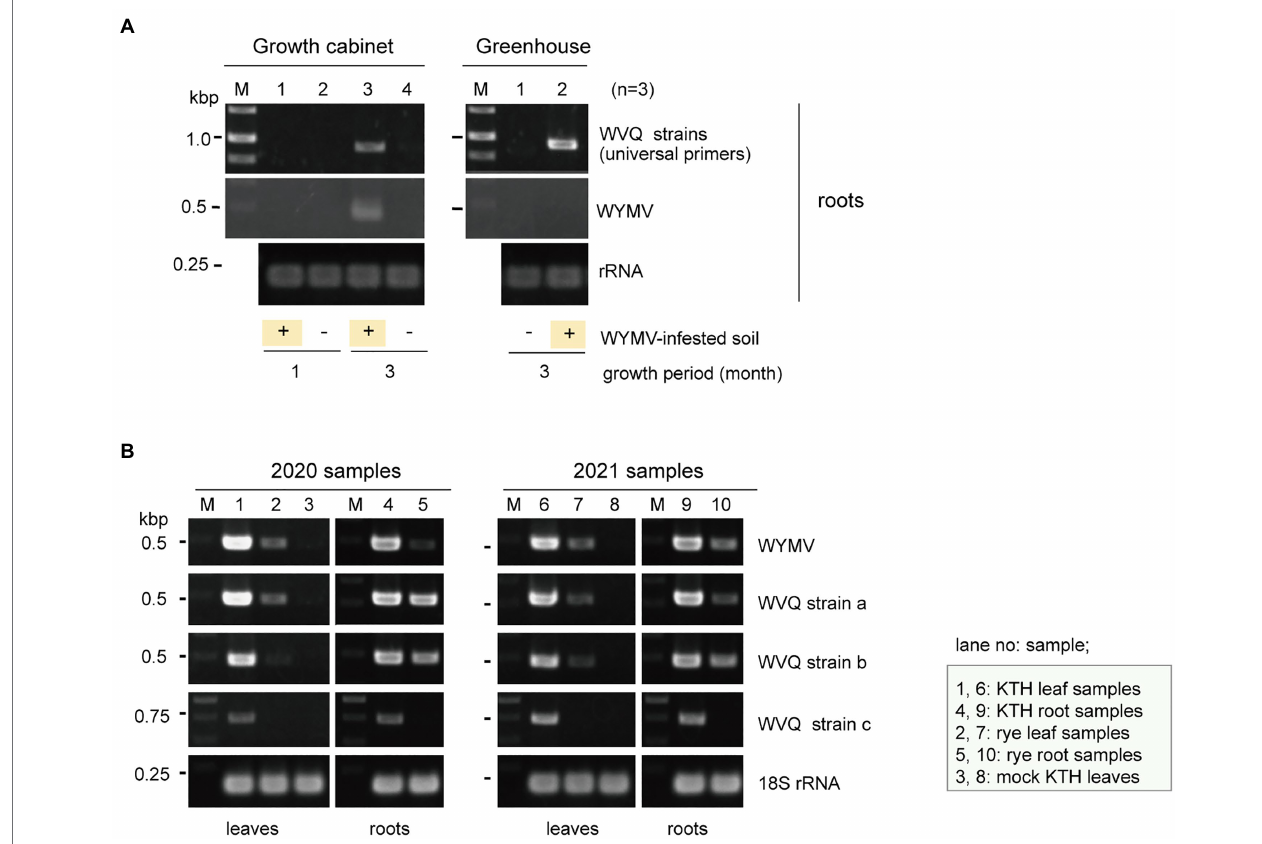
FIGURE 6 | (A) Transmission assay of WVQ. RT-PCR detection of viruses in the roots of wheat plants planted in WVQ and wheat yellow mosaic virus (WYMV)- infested soil. Wheat grains were sown in pots containing the field soil and grown under the growth-cabinet condition (below 16 ° C) or the greenhouse condition (non- controlled temperature). Three pots for each treatment were used. Total RNA fractions from the root samples were pooled according to the treatment and subjected to RT-PCR analysis with a common primer set for the WVQ strains. (B) RT-PCR detection of WVQ and WYMV in leaves or roots of wheat or rye plants. Sample names and their respective tissue origin are shown below the panel or in the bottom right. Lanes 3 and 8 are RNA samples of mock-inoculated plants. KTH, cv. Kitahonami; rye, cv. Fuyumidori. The wheat 18S rRNA gene was used as an endogenous RNA reference. The primers used in the RT-PCR analyses are listed